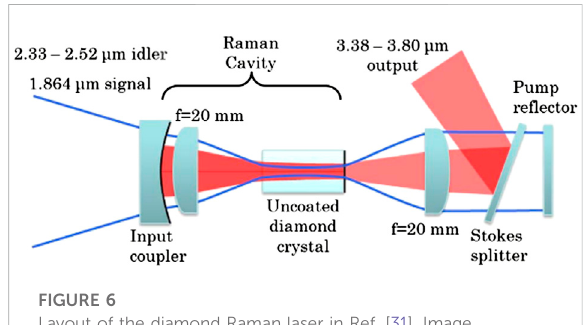
FIGURE 6 Layout of the diamond Raman laser in Ref. [31]. Image originally published in Ref. [31] and reproduced with permission from Optica Publishing group © The Optical